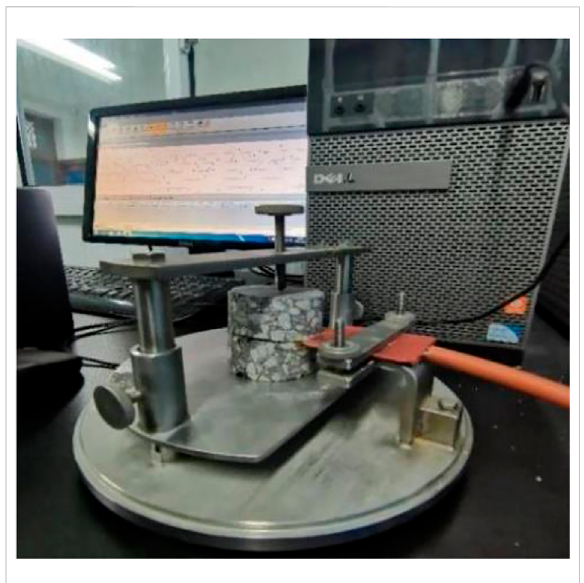
FIGURE 5 Thermal conductivity test of the cylinder concrete